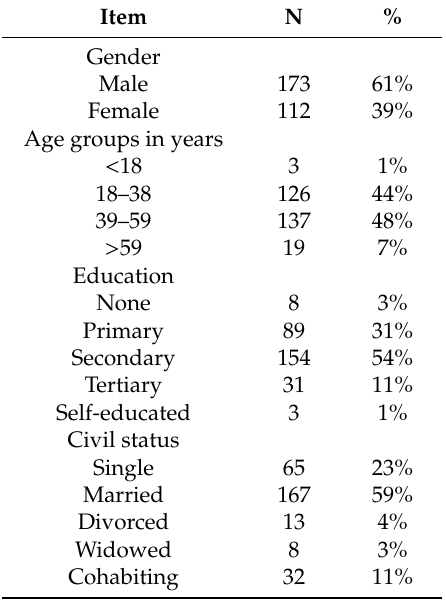
Table 1. Demographic features of the sample (N = 285)